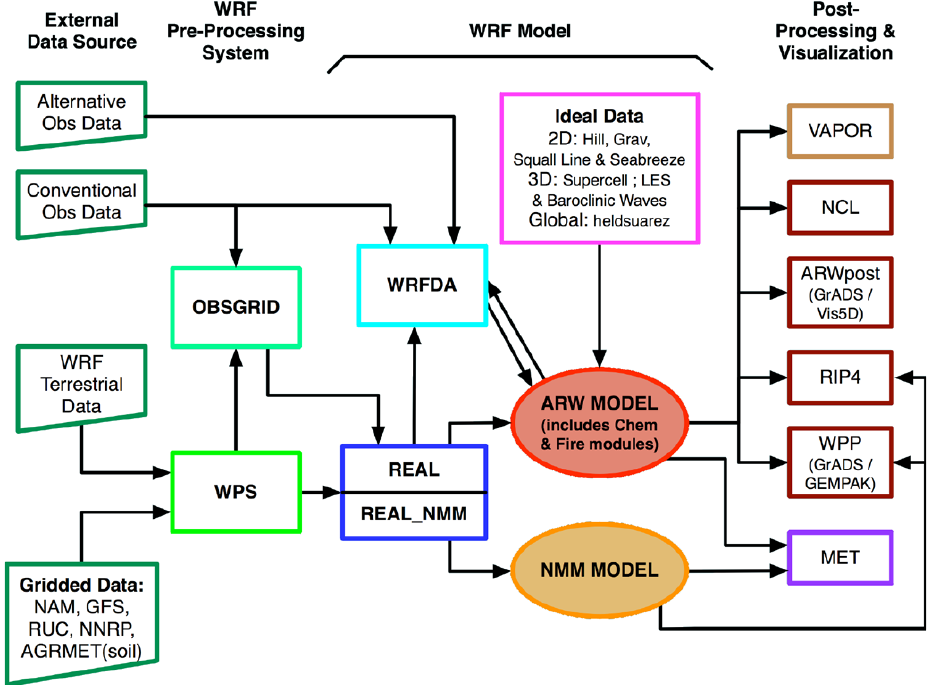
Fig. 1. A schematic of the used model environment. Mainly the WRF Modelling System consists of the WRF Preprocessing System (WPS) and the physical numerical core Advanced Research WRF (ARW). The NMM core is an alternative used in operational weather forecast (from Wang et al.,